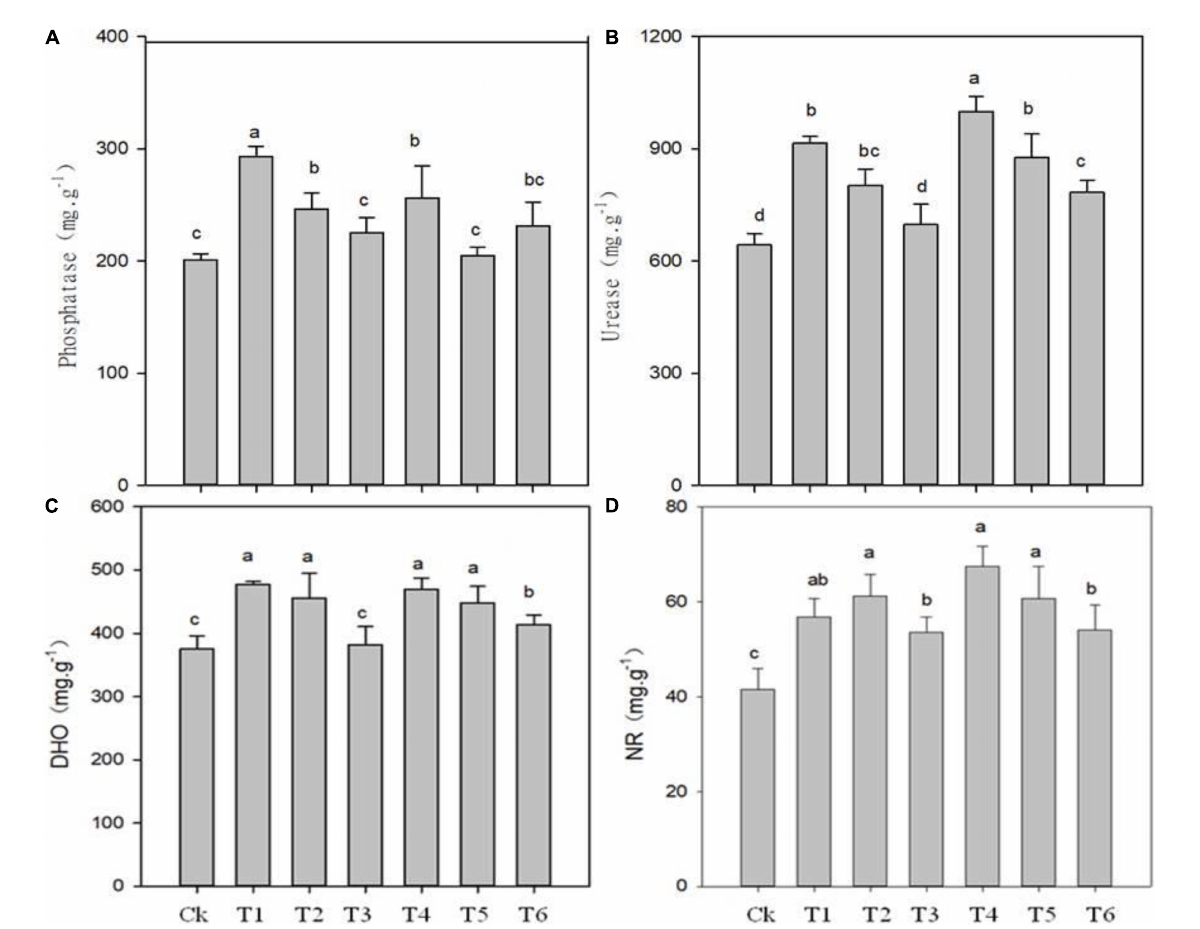
Different letters within the column indicates significant difference at P < 0.05. Ck (control), T1 (2 kg biochar plant − 1 ), T2 (4 kg biochar plant − 1 ), T3 (2 kg organic-inorganic mixed fertilizerplant − 1 ),T4(4kgbiochar + 1.7kgorganic-inorganicmixedfertilizerplant − 1 ),T5(4kgbiochar + 1.4kgorganic-inorganicmixedfertilizerplant − 1 ),T6(4kgbiochar + 1.1kg